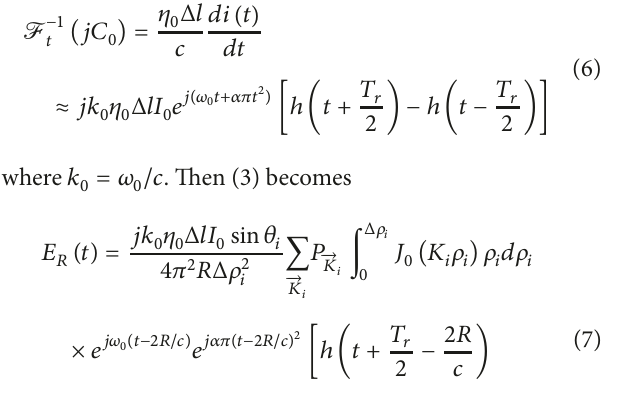
Figure 3: Scattering geometry for ionospheric